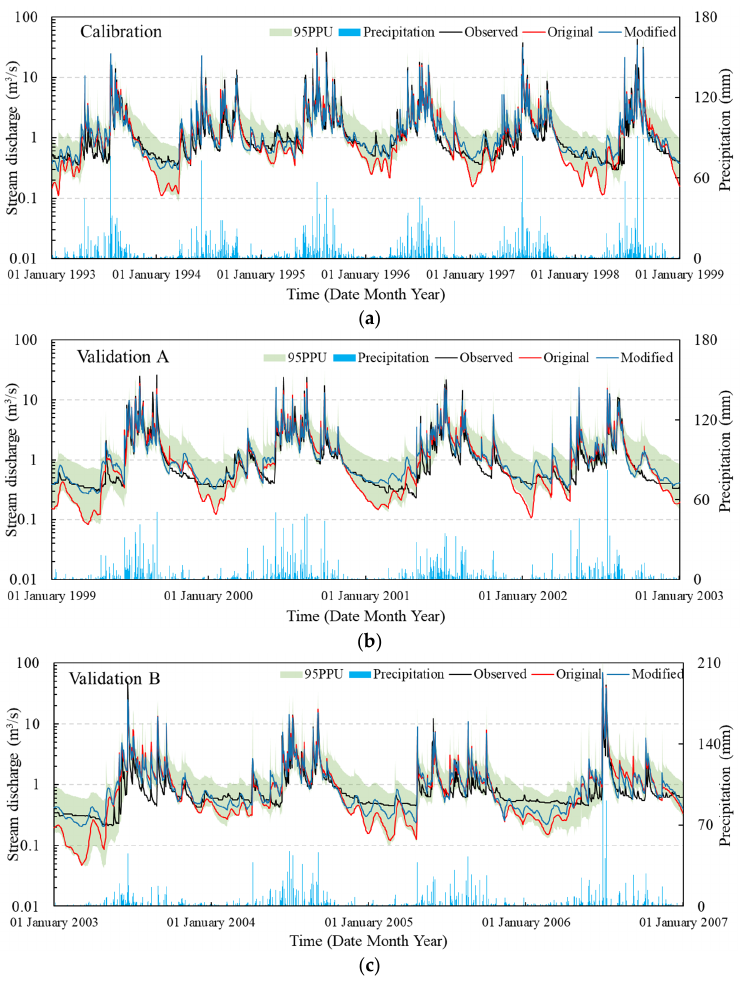
Figure 7. Simulated daily flow during the calibration period ( a ) and validation periods A ( b ) and B ( c ) obtained using the original and modified SWAT models. The green band denoted the 95PPU of the modified SWAT